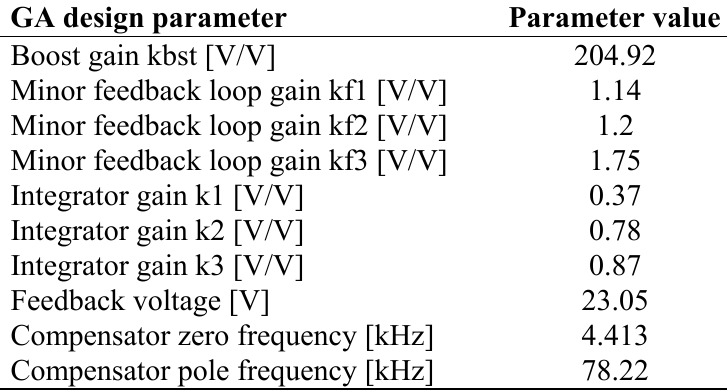
Table 4. Final Design Parameters.